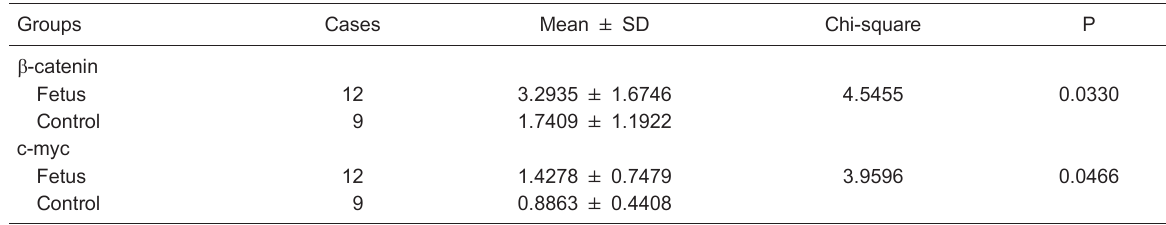
Table 1. Analysis of b -catenin and c-myc expression by Western blot. Groups